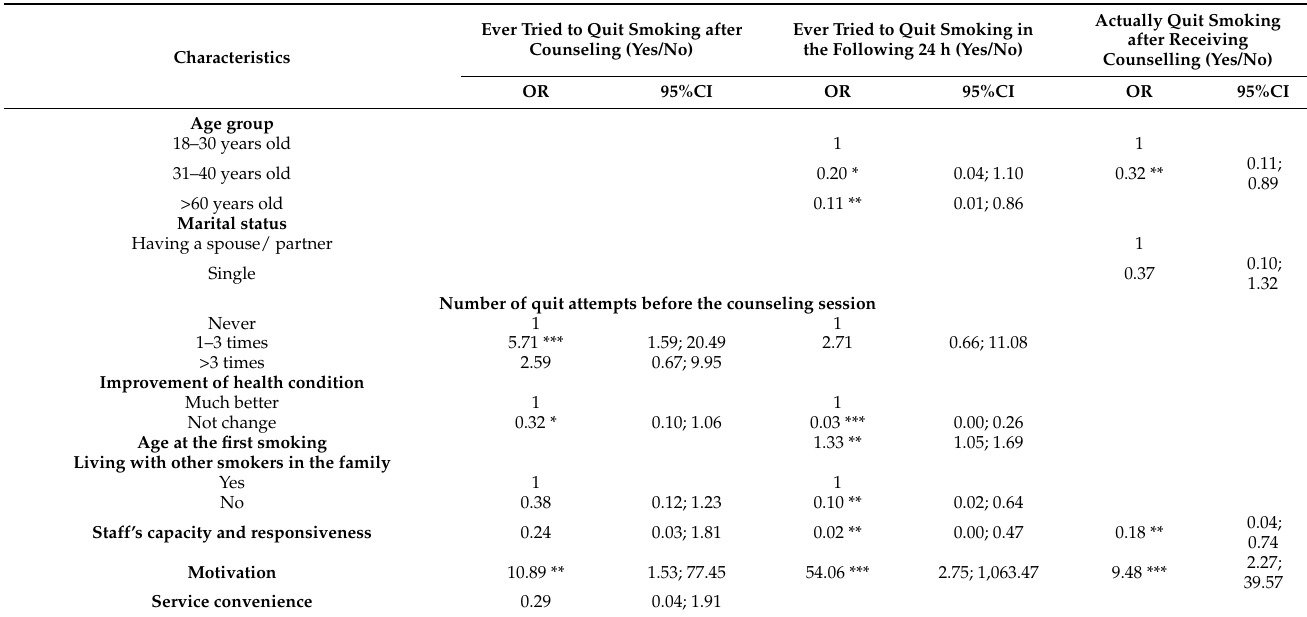
Table 5. Associated factors with quit attempts and current smoking